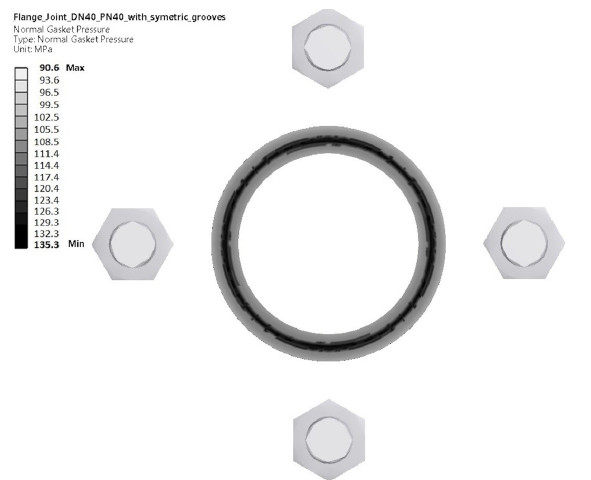
Figure 13: Contact stress distribution on the gasket surface in case of the joint gasketed with the symmetrically grooved gasket’s core